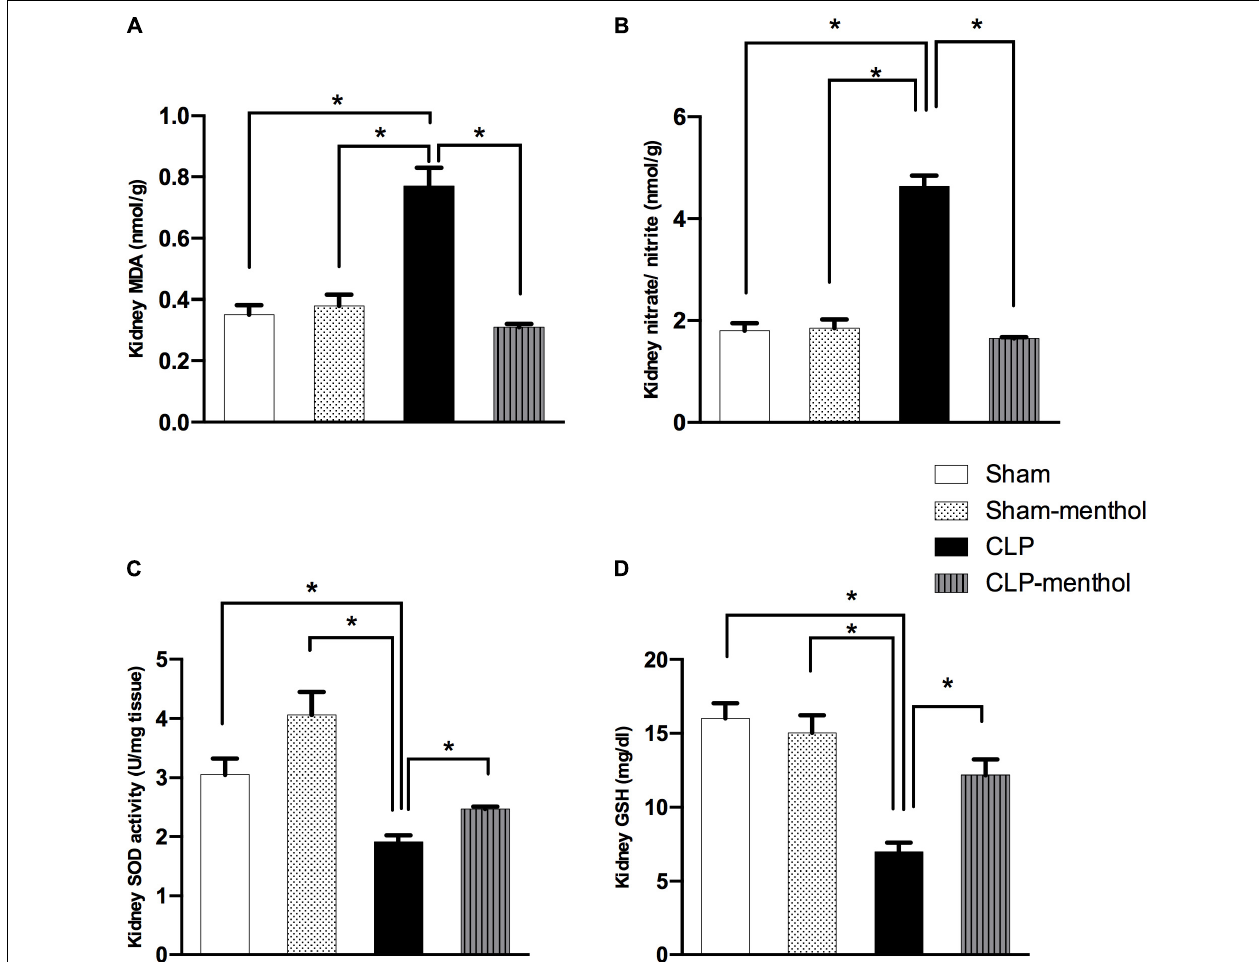
FIGURE 5 | Menthol treatment attenuates renal oxidative stress and restores the antioxidant capacity of renal tissue. Cecal ligation and puncture enhanced oxidative stress which is normalized by menthol (100 mg/kg, p.o), 2 h after surgery as shown with the results of (A) , malondialdehyde (MDA), (B) nitrate/nitrite, (C) activity of superoxide dismutase (SOD) and (D) , reduced glutathione (GSH). n = 6 per group. Data were analyzed by one-way ANOVA followed by Tukey-Kramer post-test for multiple comparison. Data represent the mean ± SEM of 6 independent observations. *Significantly different from the CLP group at p <